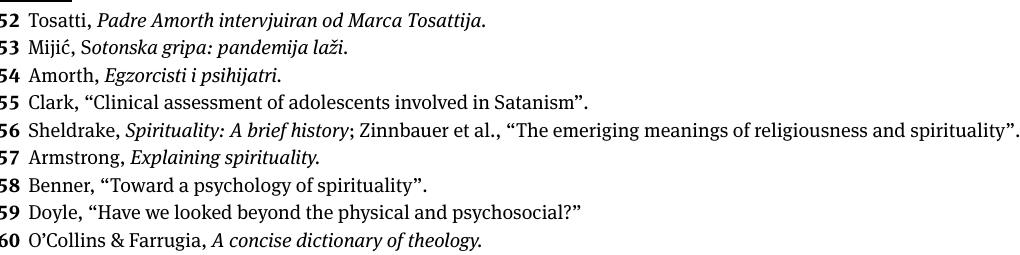
The Satanic syndrome Sex Nationality Males Females Croats Serbian ethnic minority Predictors (beta) (beta) (beta) (beta) Psychopathy